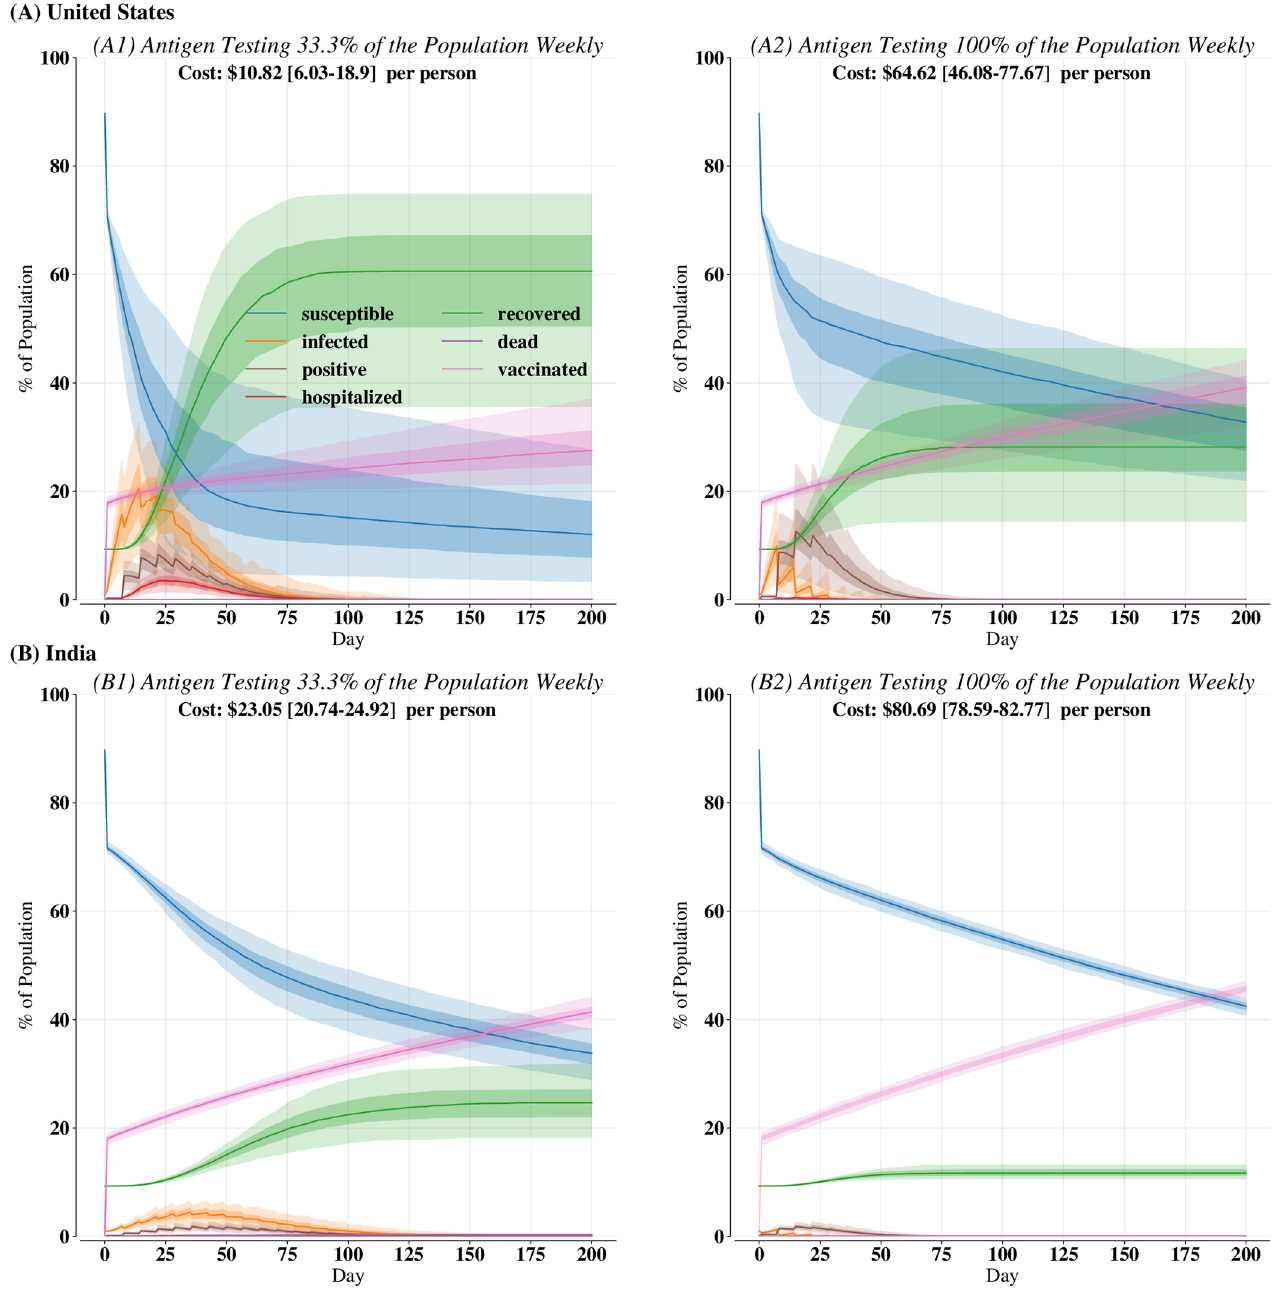
Fig 4. Disease course for (A) United States and (B) India with 20% of the population as initially vaccinated and then 0.25% of the susceptible population being vaccinated each subsequent day; vaccines are coupled with antigen testing (1) 33.3% or (2) 100% of the population weekly. Bold lines are the median over 200 independent replicates. Dark-shaded regions are the 25th to 75th percentiles over the 200 independent replicates; light-shaded regions are 2.5th to 97.5th